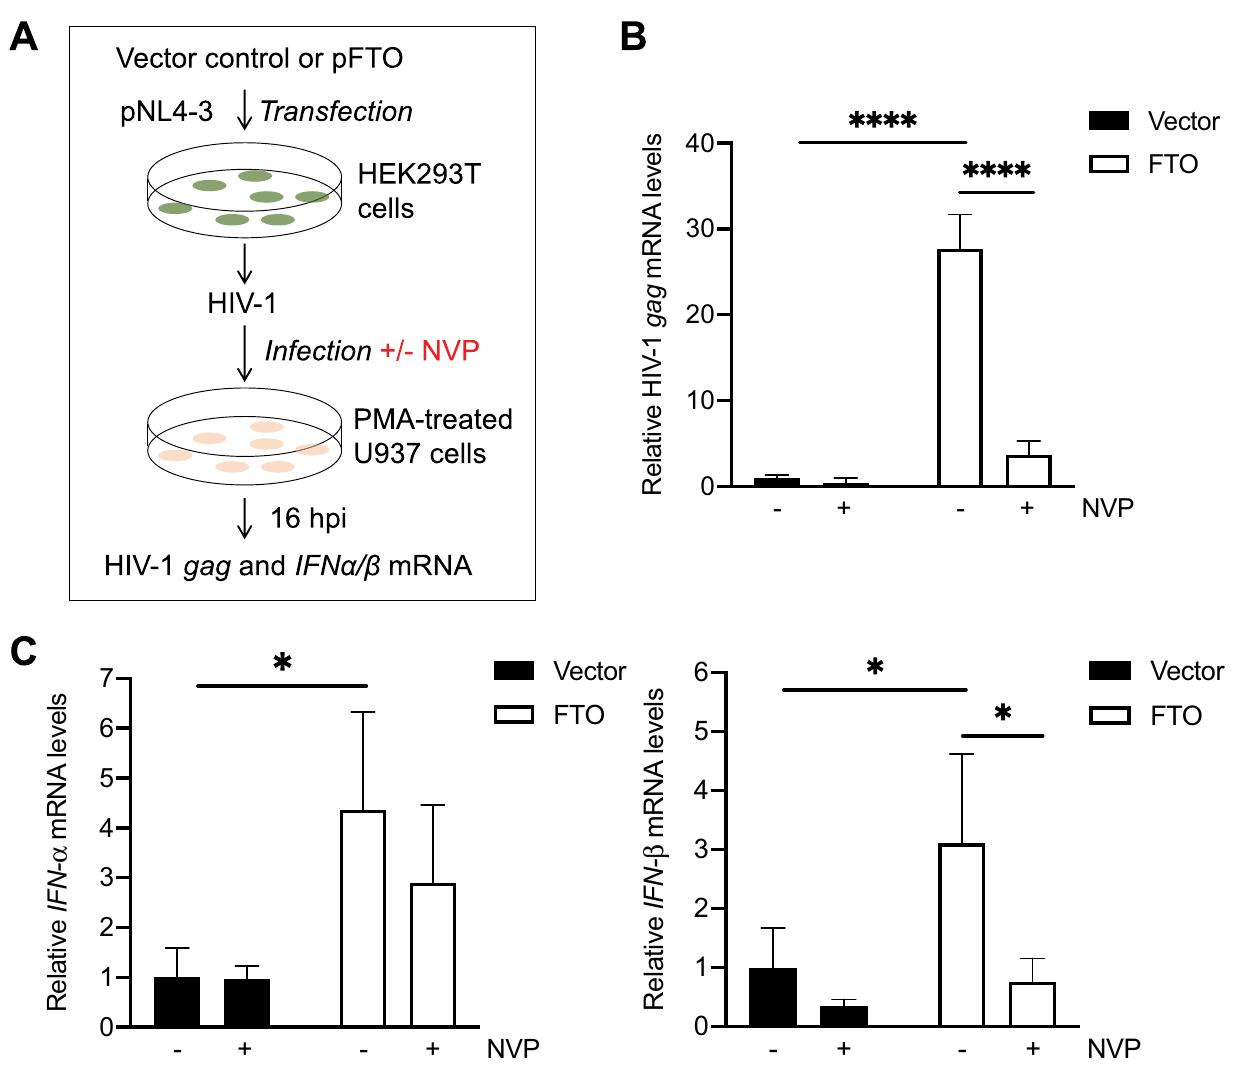
Fig 4. Blocking HIV-1 reverse transcription partially reduces m 6 A-deficient HIV-1 induced IFN-I expression in U937 cells. (A) A schematic diagram of the experimental approach. (B-C) PMA-differentiated U937 cells in the nevirapine (NVP) groups were pre-treated with NVP (5 μ M) for 2 hr prior to 2 hr incubation with HIV-1 NL4-3 (250 pg of p24) generated from vector control or FTO-overexpressing HEK293T cells. NVP (5 μ M) was maintained in the medium throughout the infection and subsequent culture. At 16 hpi, mRNA levels of (B) HIV-1 gag and (C) IFN- α and IFN- β were quantified by RT-qPCR. Spliced GAPDH was used as a normalization control (B-C). The results are shown as means ± S.D. of triplicated samples. One representative experiment of four repeats is shown. Two-way ANOVA was used for statistical analysis. � P � 0.05, ���� P � 0.0001.